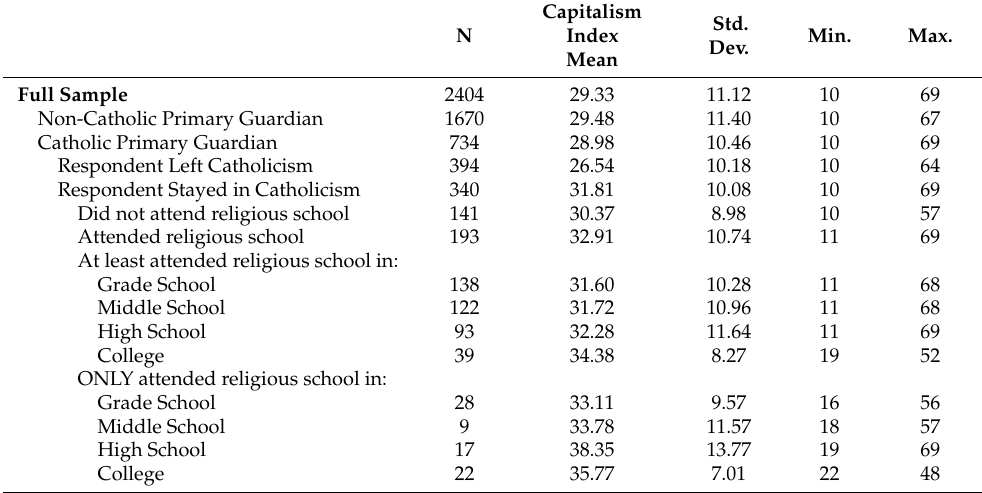
Table 2. Capitalism index by religious school